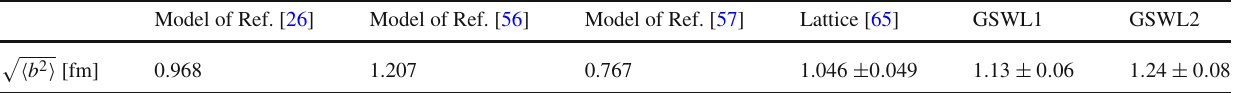
Table 3 Values of the mean partonic distance in the pion, Eq. (45), obtained in lattice QCD [65] and in models based on the AdS/QCD approach [26,56,57] Model of Ref. [26] Model of Ref. [56] Model of Ref. [57] Lattice [65]